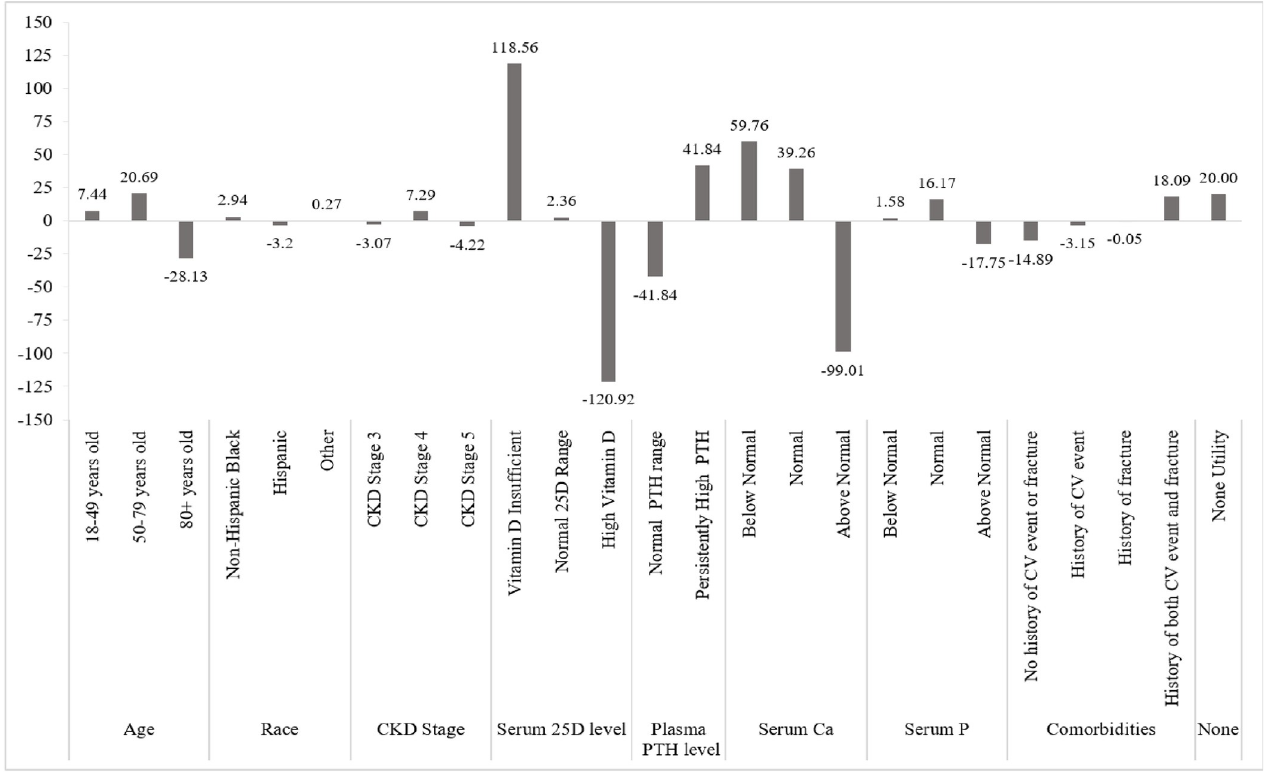
Fig 3. Average part-worth utilities. Displayed by patient attribute and levels within each attribute.